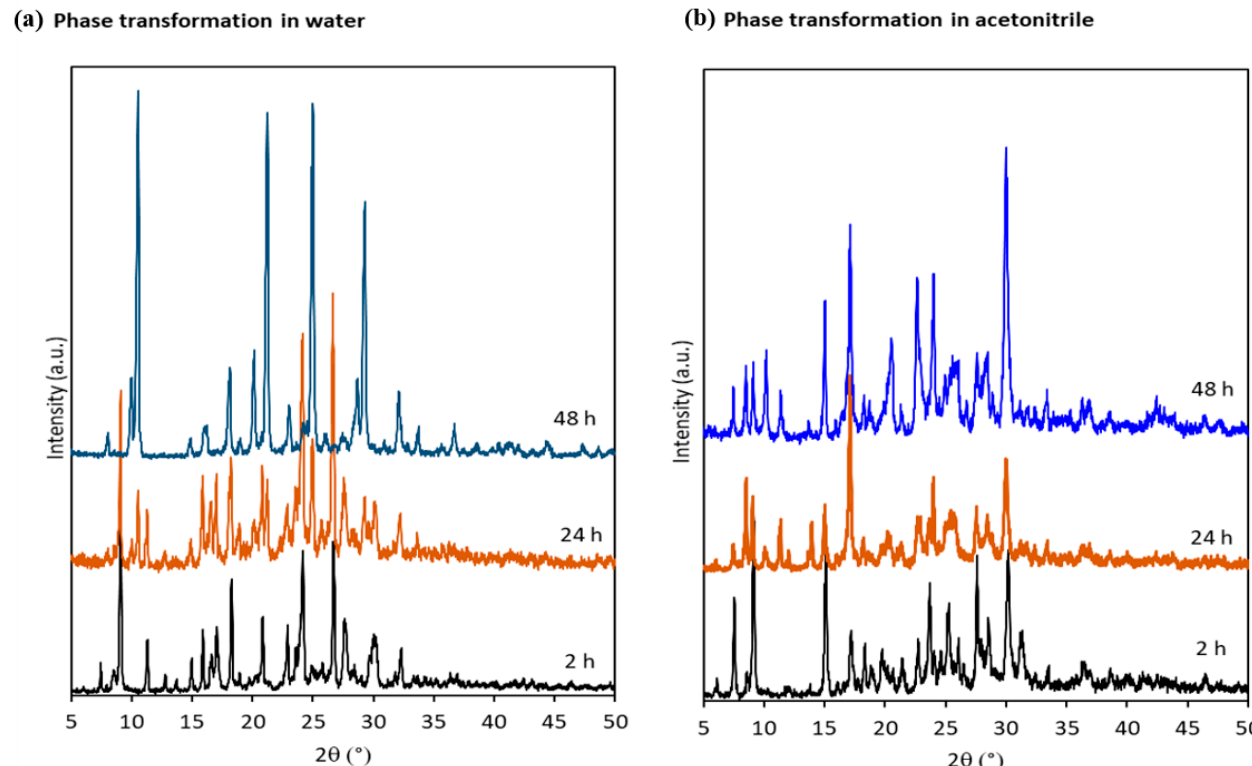
Figure 5. Phase transformations in slurry experiments in ( a ) water or ( b ) in